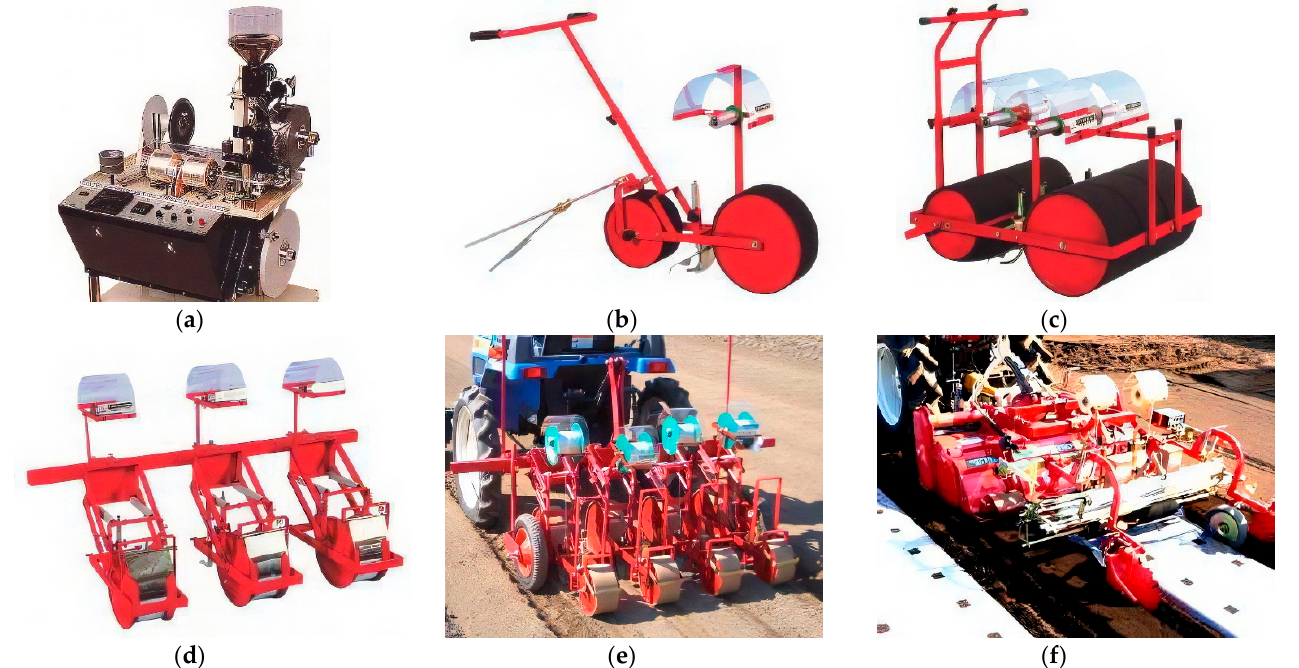
Figure 11. Seeder machine and tape seeders of Nippon. ( a ) SMV-1J type rope twisting machine; ( b ) TSA-7 seeder; ( c ) TSD-7 seeder; ( d ) TRA-7x seeder; ( e ) TRA-8st; ( f ) SDM-T354F. (http://www.plantseeder.co.jp/en.html (accessed on 8 October